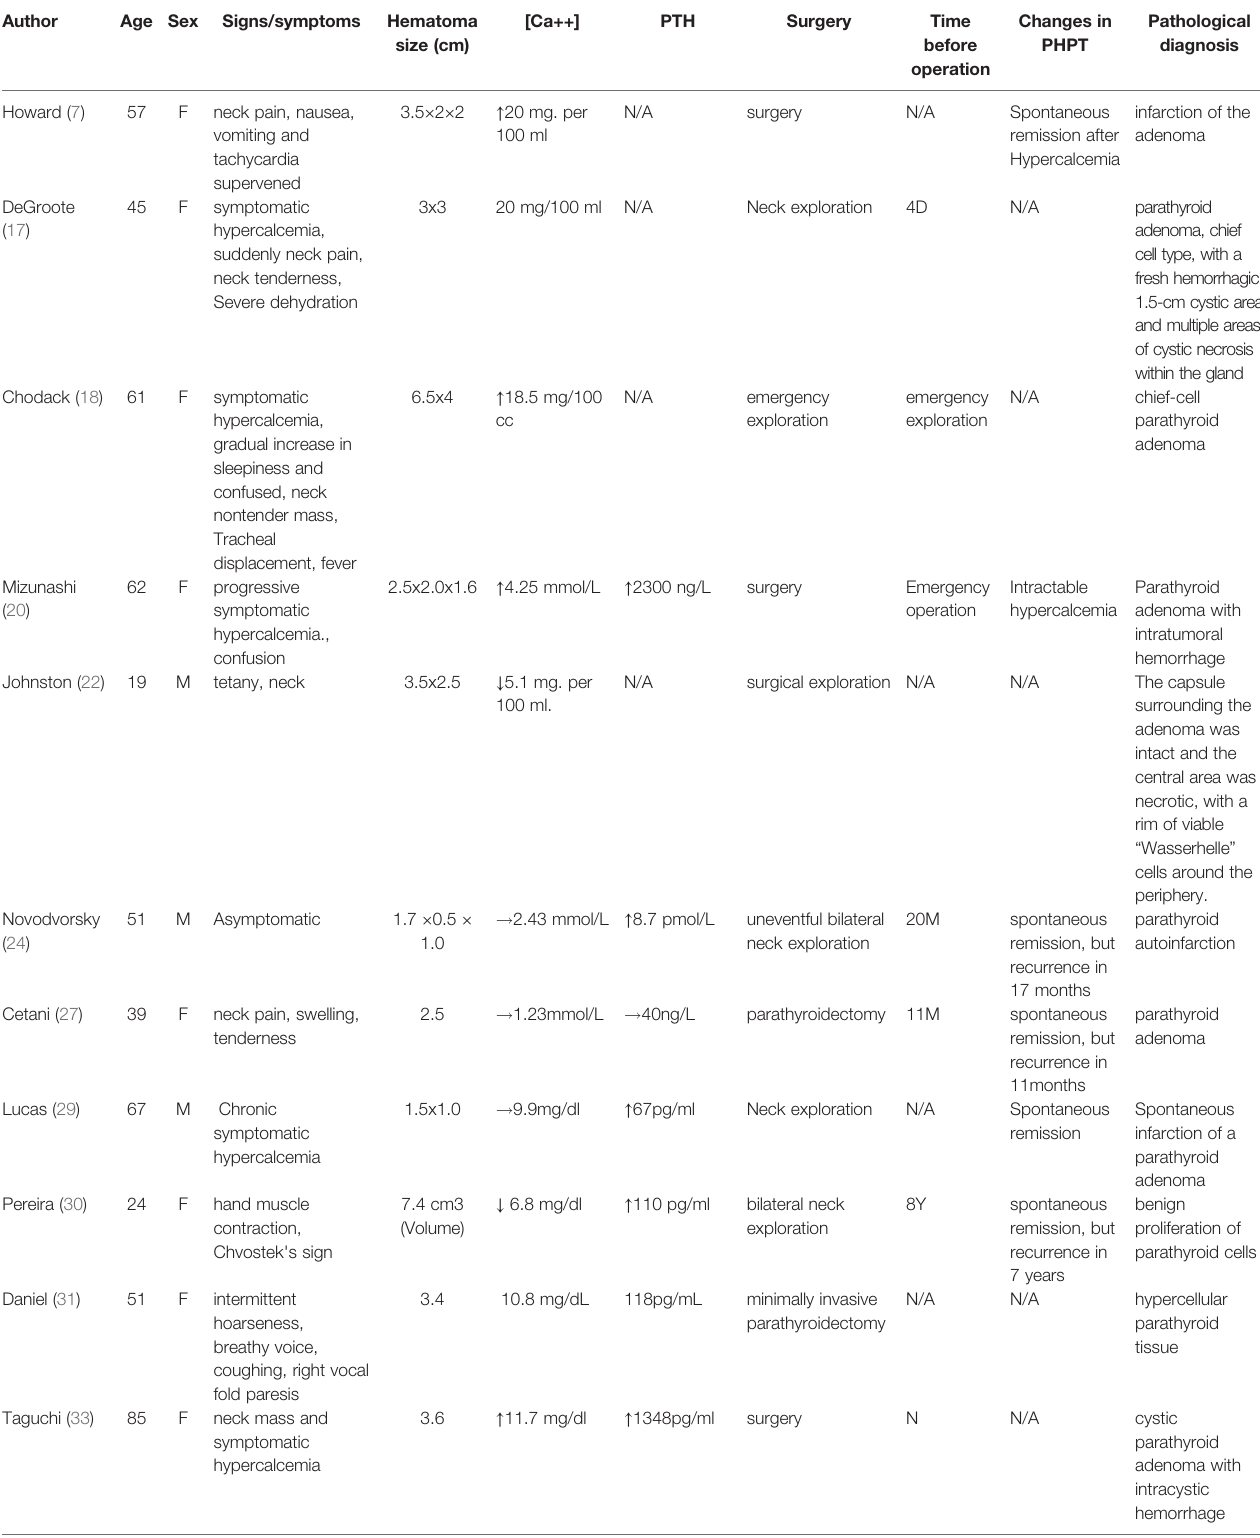
TABLE 2 | Case analysis of intracystic hemorrhage or necrosis of in situ primary parathyroid adenomas (Operated patients, n =